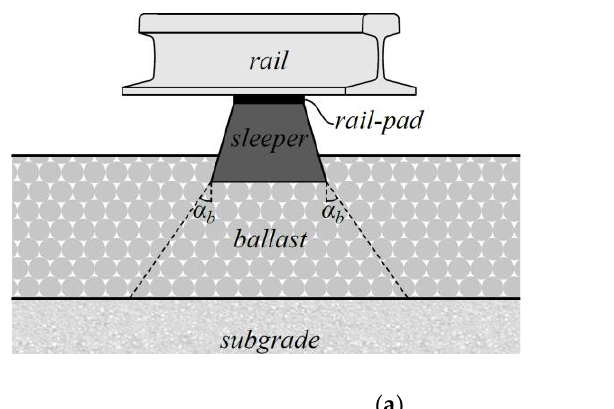
C , C C and b f w